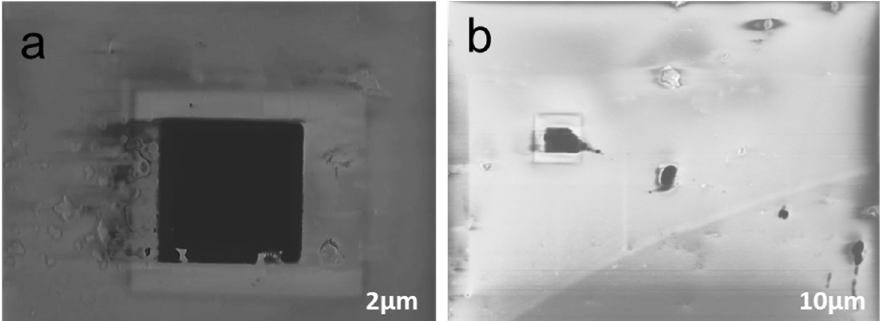
Figure 6. Effect of high concentration of HF (20%) in electrolyte with 15 V. ( a ) 70% cavity is etched under J = 8.6 mA/cm 2 ; ( b ) micro/nanopores with size varying from 140 nm to 2.8 μ m produced near the actual etched cavity.